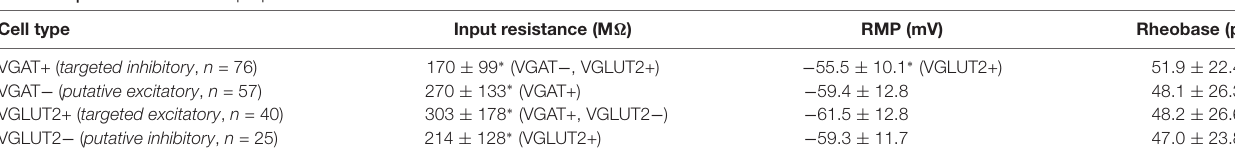
TABLE 1 | Passive membrane